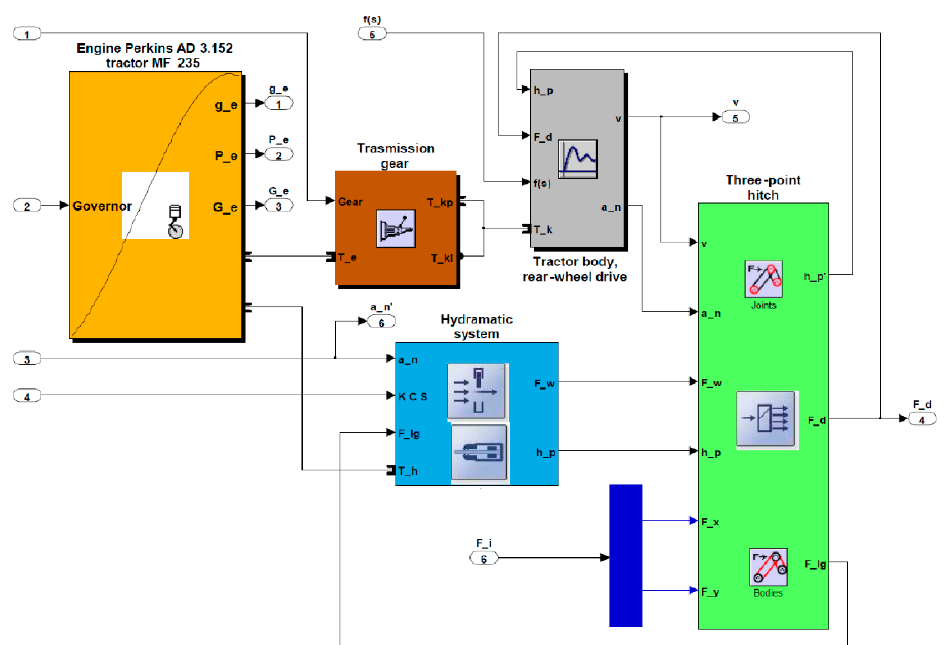
Figure 5. General layout of the Simulink suite program for simulation studies of the machine unit.